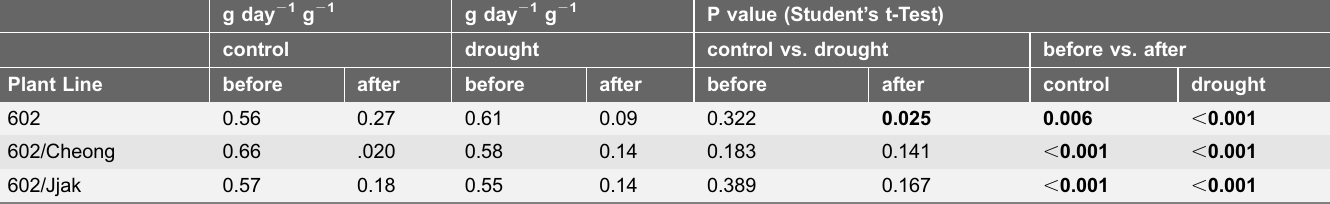
Table 4. The Relative growth rates (RGR) for three lines of tomato experiencing either control conditions or a mild-drought are